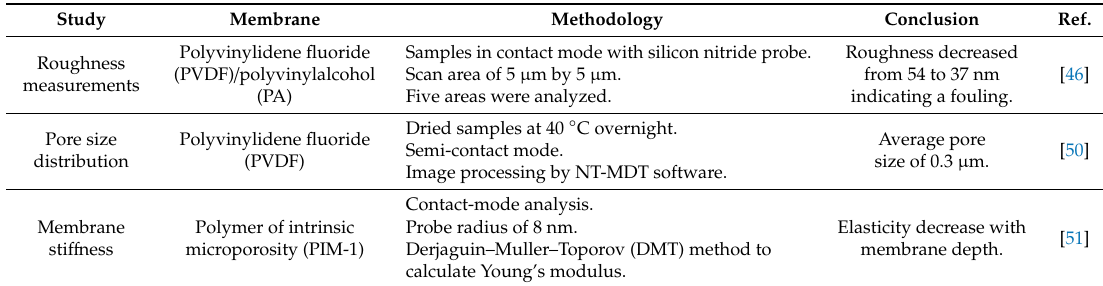
Figure 12. Use of AFM for the measurements of the stiffness of polymer of intrinsic microporosity (PIM ‐ 1) membrane by plotting the force versus displacement and indentation. Young’s modulus was calculated based on the Derjaguin–Muller–Toporov (DMT) method [51]. Table 3. Studies performed by AFM for membrane characterization.